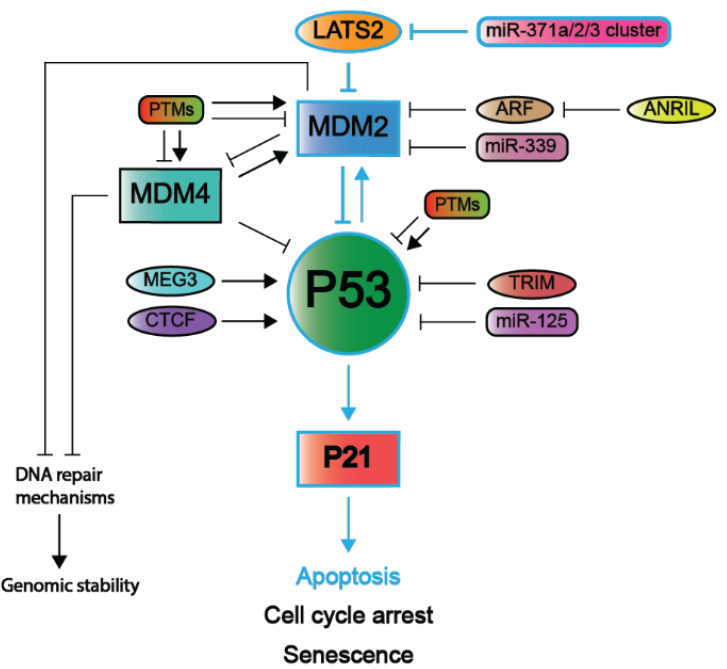
Figure 7. The regulatory mechanisms of the P53 pathway. P53 is regulated by MDM2 and MDM4, which are all affected by the PTMs and are also determining each other’s activity. MDM2 is indirectly activated by miR-cluster 371a-3 and ANRIL, while it is inhibited by ARF and miR-339. MEG3, CTCF, TRIM proteins, and miR-125 can regulate P53 activity directly. All these regulatory mechanisms combined will lead to the inhibition or activation of P21 expression, leading to apoptosis, cell cycle arrest, or senescence. MDM2 and MDM4 are both able to inhibit DNA repair mechanisms, resulting in genomic instability.